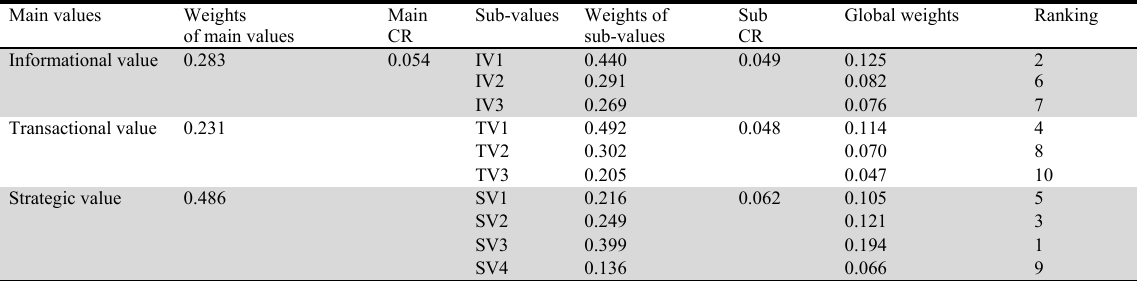
Aggregate weights of Main values and sub-values Main